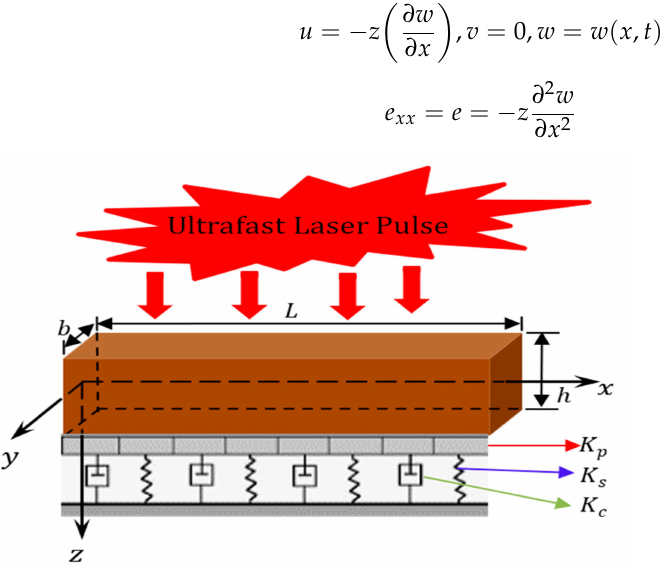
Figure 2. Thin, flexible beam resting on visco-Pasternak’s foundation that is induced by an ultrafast laser